Question: Provide a publication-style caption for this figure.
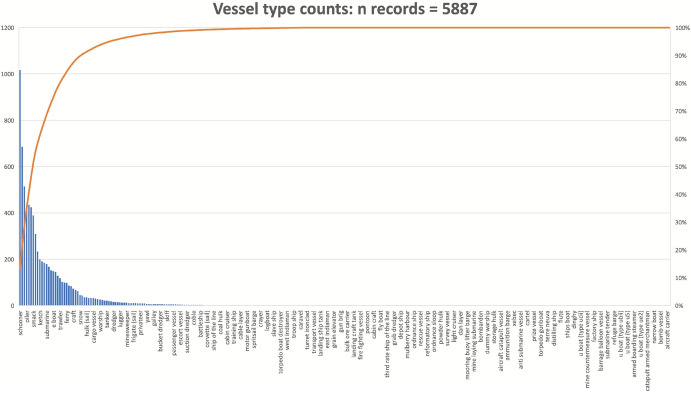
Answer: Chart showing the number of examples for each FISH maritime craft thesaurus entry within the Coflein database (image by the authors)